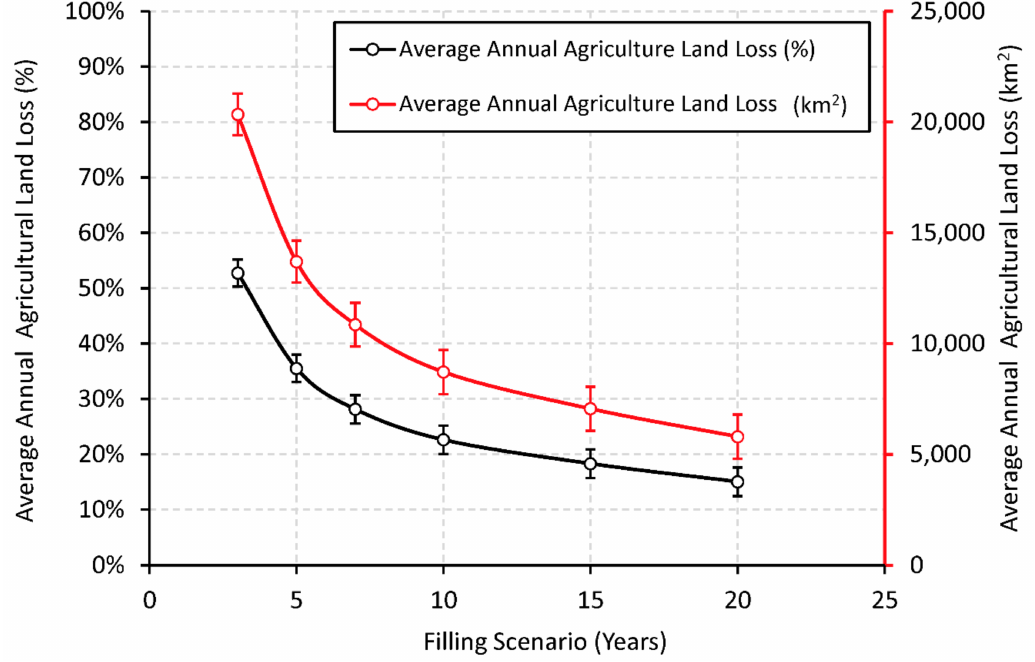
Figure 4. Impact of the GERD on Egypt’s agriculture land (in km 2 and %) as function of filling scenario (in